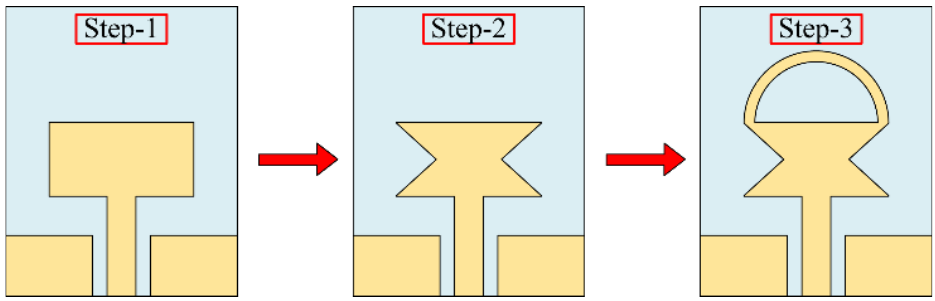
Figure 2. Different antennas are utilized to achieve the proposed UWB antenna